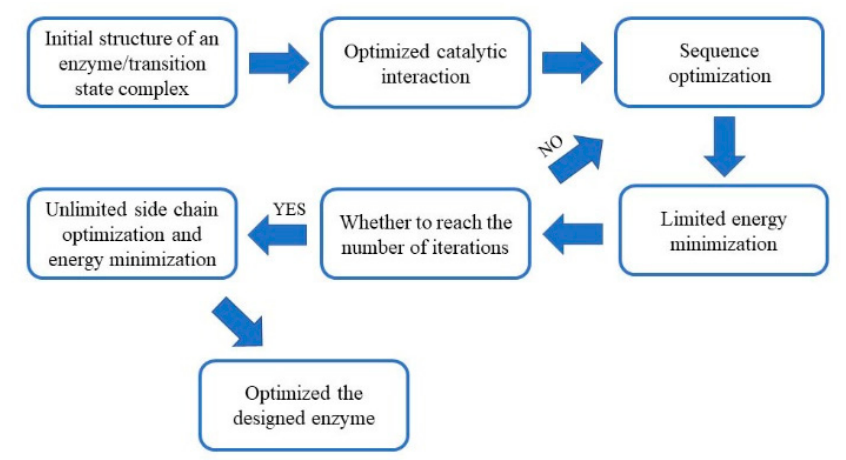
Figure 1. The enzyme design scheme implemented in this study.